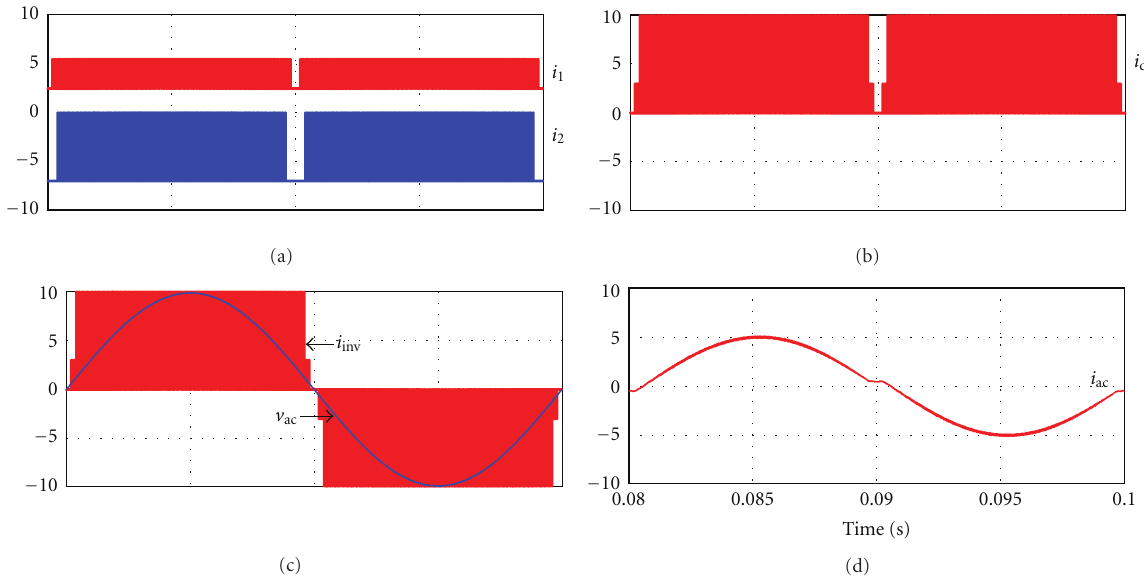
Figure 16: Operation of the system under the conditions of m pv > m wind , I pv < I wind , f line = 50Hz and f sw = 20kHz (top to bottom) i 1 , i 2 , i i i dc , inv , and ac .